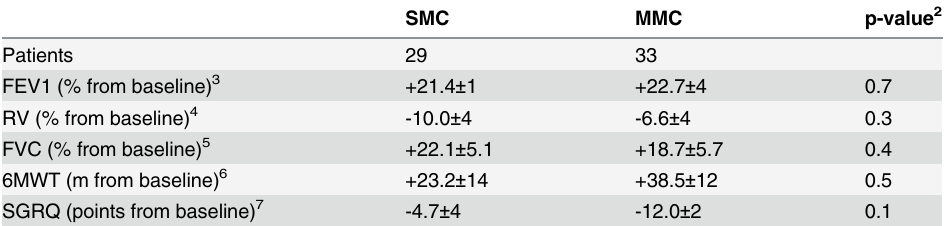
Table 4. Comparison of clinical outcomes at 3 months after ELVR 1 vs.